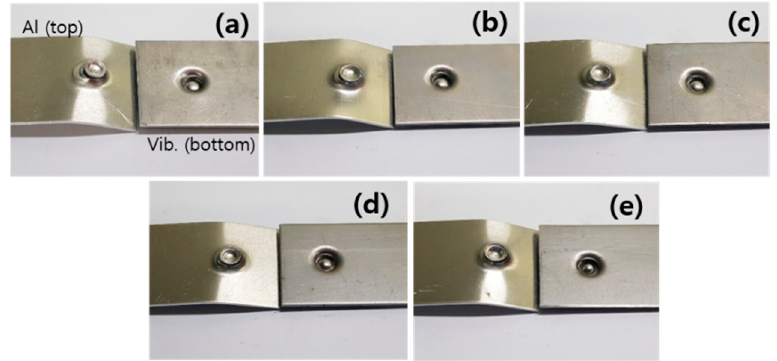
Figure 13. Failure modes for SPR joint of Al5052-H32 (top) and vibration-damping steel (bottom) with respect to SPR die type. ( a ) Type A1 die, ( b ) type A2 die, ( c ) type A3 die, ( d ) type B die, and ( e ) type C die.